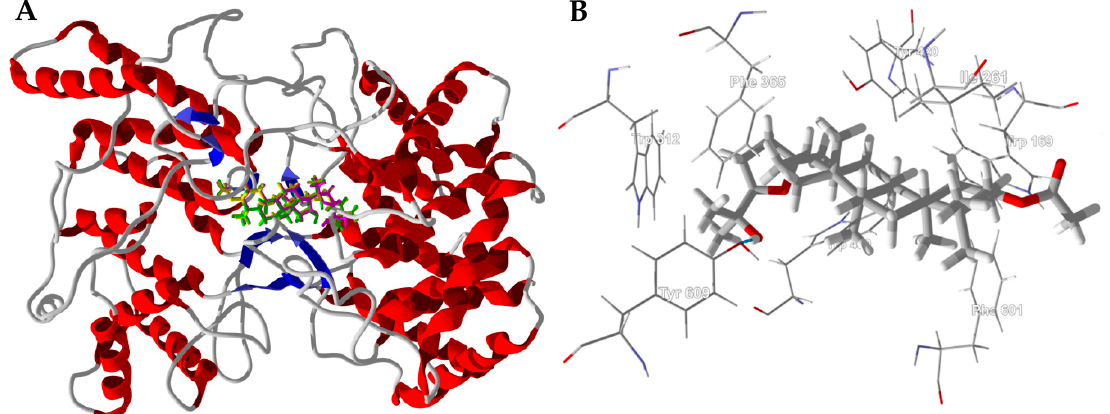
Figure 14. Alicyclobacillus acidocaldarius oxidosqualene cyclase (AaOSC, PDB 1h36). ( A ): Lowest energy docked poses of ocotillyl acetate (magenta), 3 β -acetoxydammar-24-ene-16 β ,20 R -diol (green), and dammarenediol II acetate (yellow) with AaOSC. ( B ): Molecular environment of docked ocotillyl acetate in the active site of AaOSC.